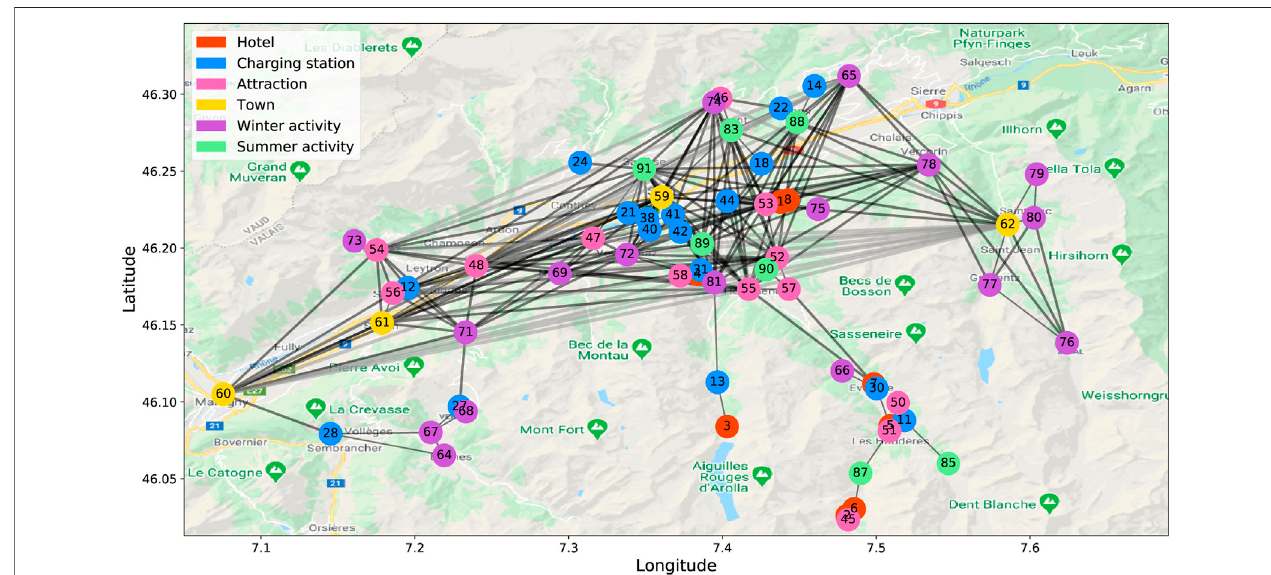
FIGURE 3 | Graph representation of the road network of the Val d ’ Hérens alpine region in Switzerland.